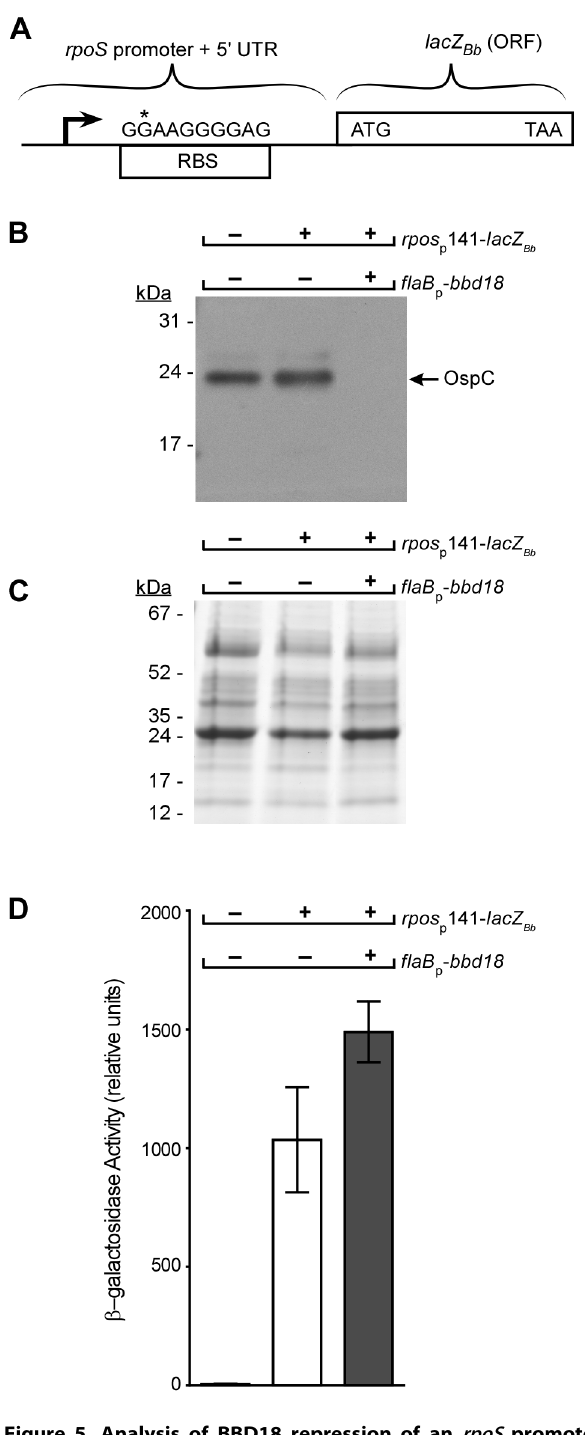
Figure 5. Analysis of BBD18 repression of an rpoS promoter lacZ Bb transcriptional fusion. (A) A schematic diagram of the transcriptional fusion of the rpoS promoter and 5’ untranslated region (UTR) fused directly to the lacZ Bb open reading frame (ORF). The position of the rpoS transcriptional start site [58,63] is indicated by a filled arrowhead. The Shine-Dalgarno sequence (RBS), and the translational start site of b -galactosidase ( lacZ Bb ), indicated by the ATG, are also shown. Regions corresponding to the rpoS promoter and 5’ UTR (141bp) or the lacZ Bb ORF are indicated with brackets. The "G" in the RBS marked with an asterisk is identified because the reporter construct harbored an A- . G mutation relative to the published sequence at that position. Cell lysates from strains B31-S9 (wt),